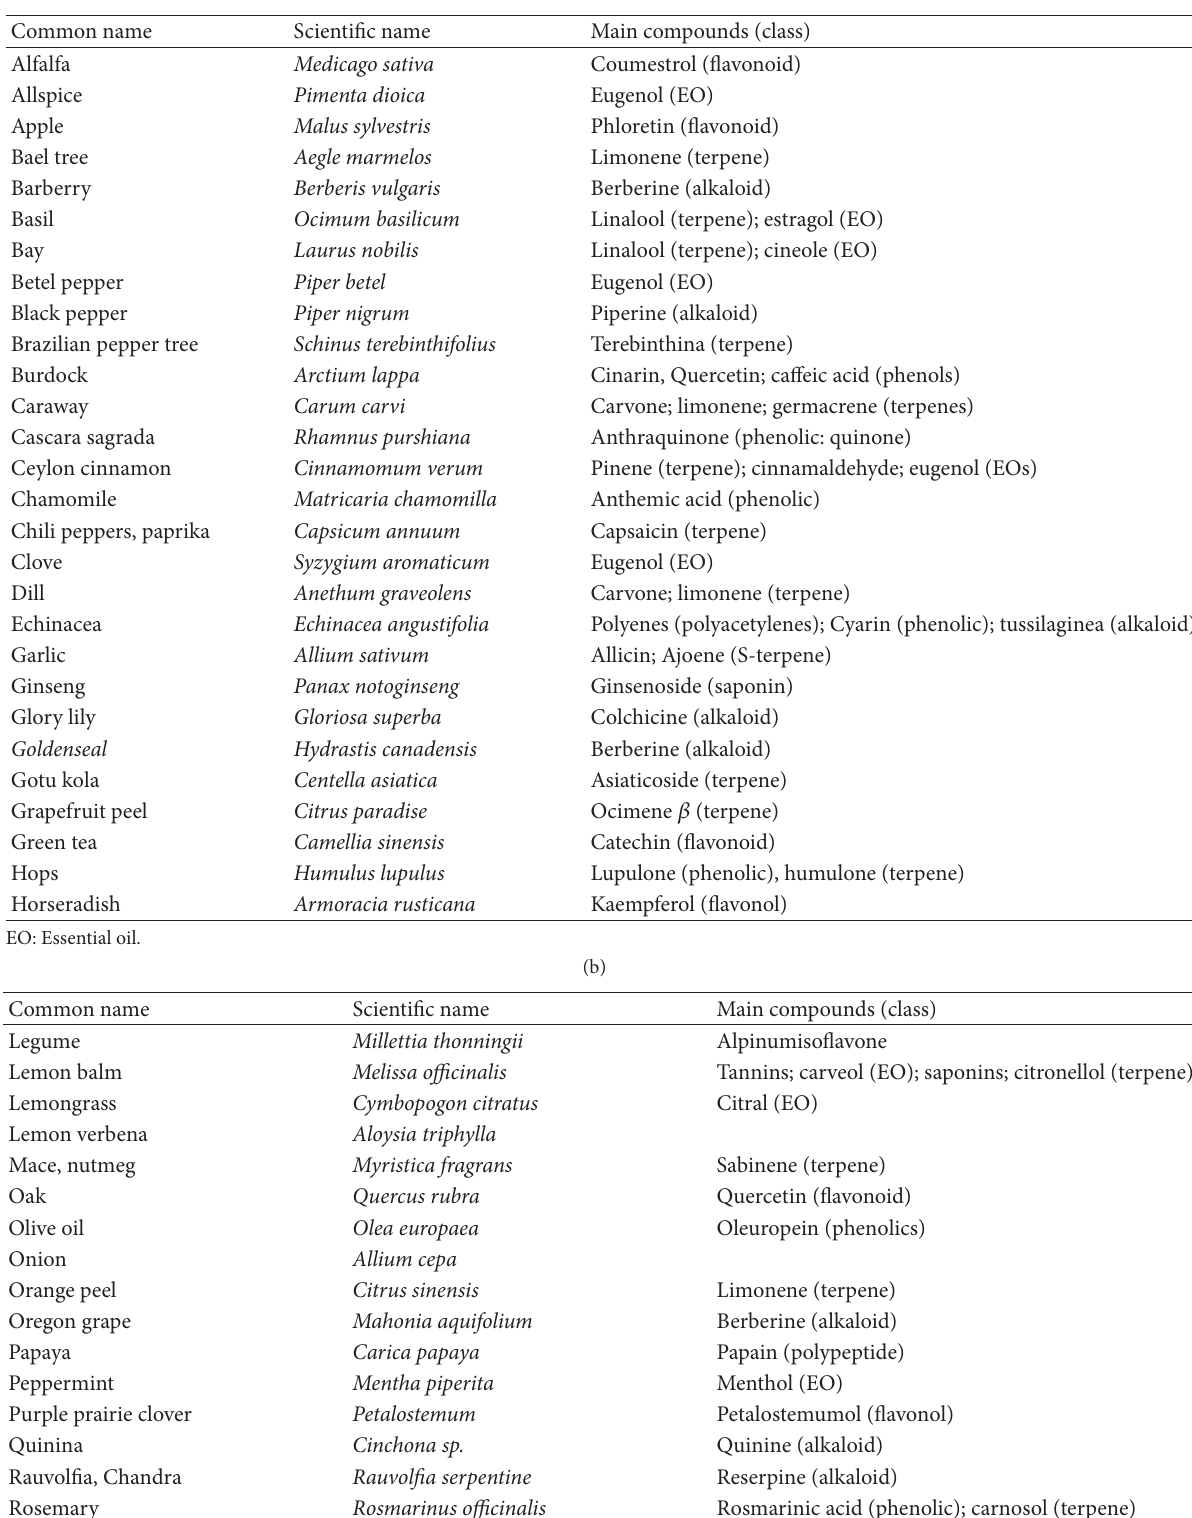
Table 3: Table representing common plant extracts and main active substances fed to cattle